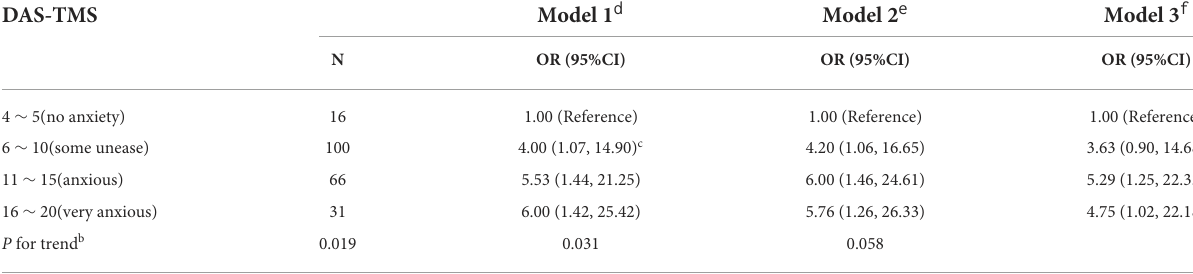
TABLE 2 Adjusted association for the categories of the dental anxiety with the severity of postoperative symptom a .